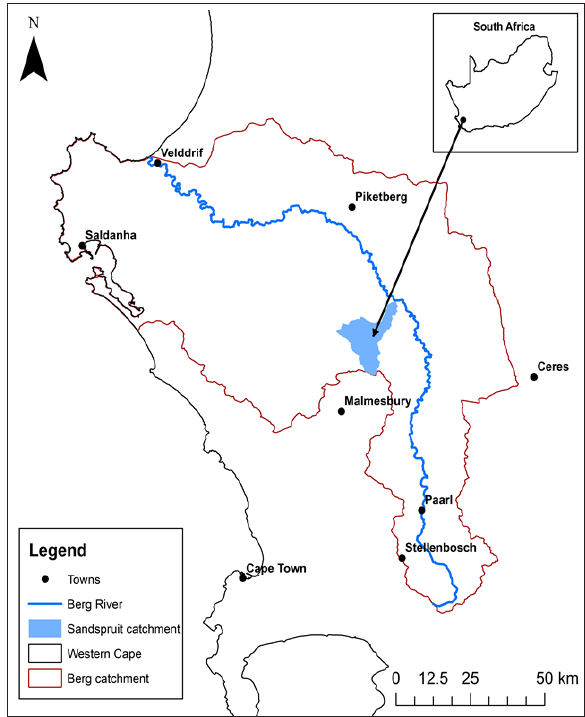
Figure 1: The locality of the study area in the Western Cape (South